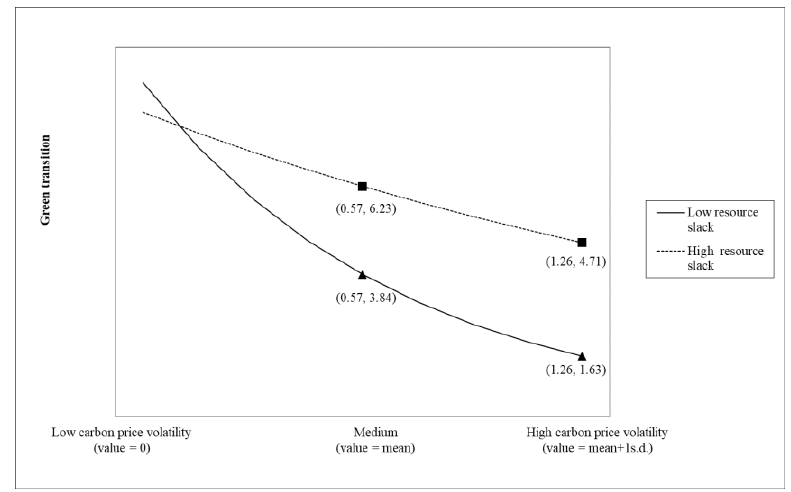
Figure 1. The moderating effect of resource slack on the green transition.